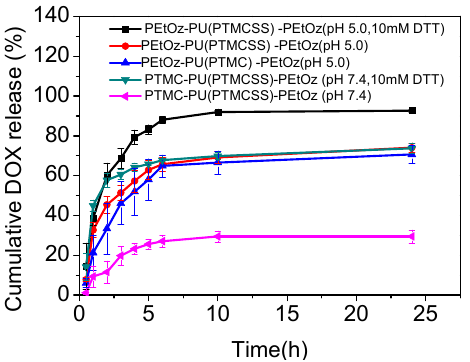
Figure 2. Reduction and/or pH triggered drug release from DOX-loaded PEtOz-PU(PTMCSS) -PEtOz micelles. PEtOz- PU(PTMC)-PEtOz micelles were used as a control.